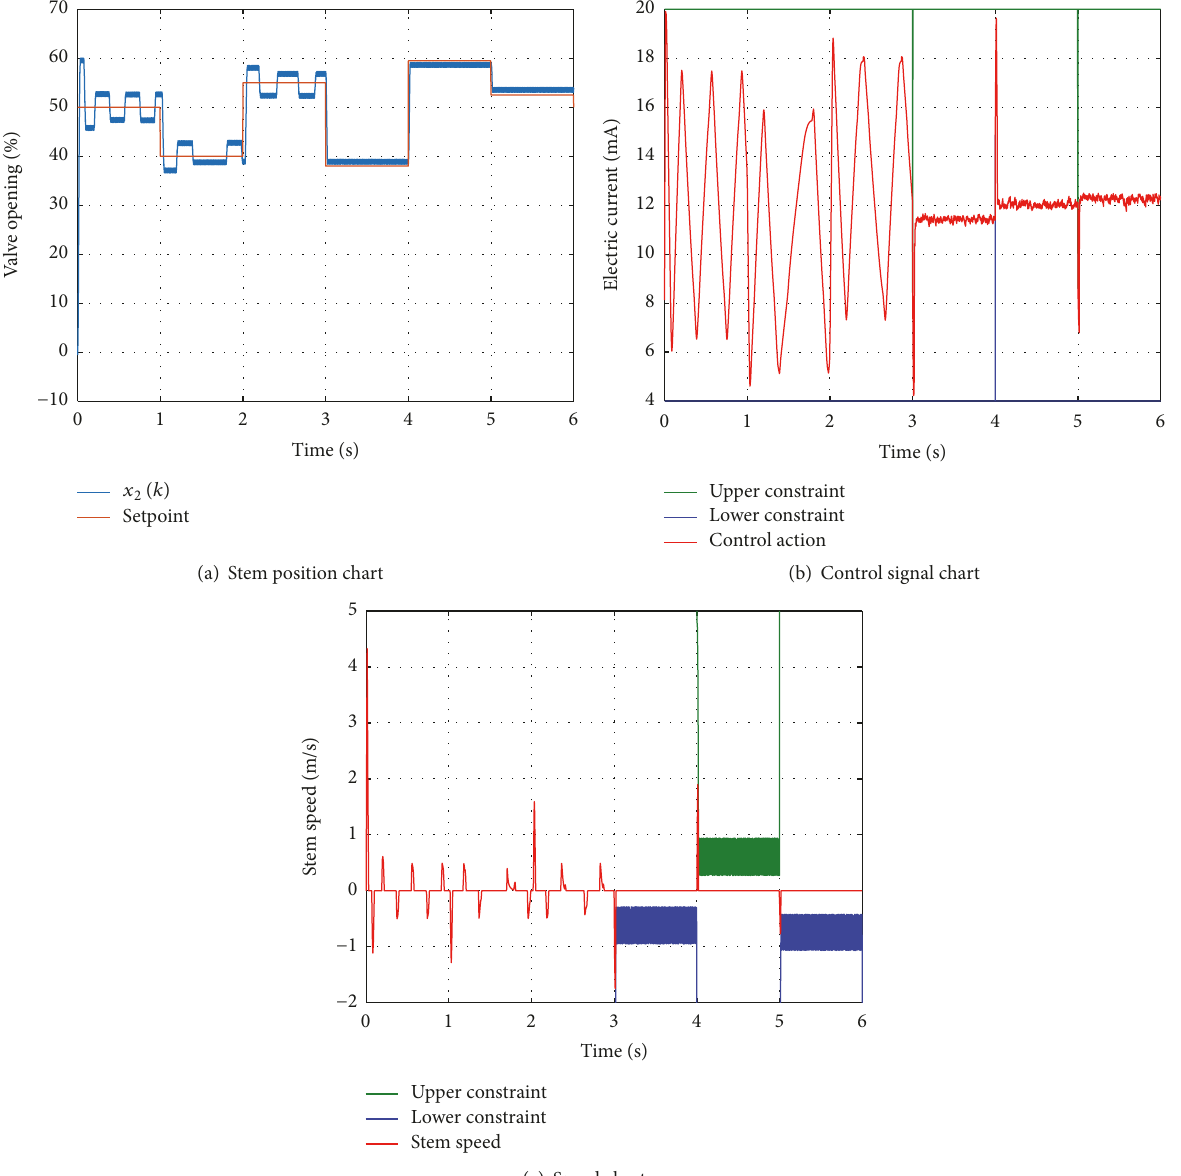
Figure 8: Simulation